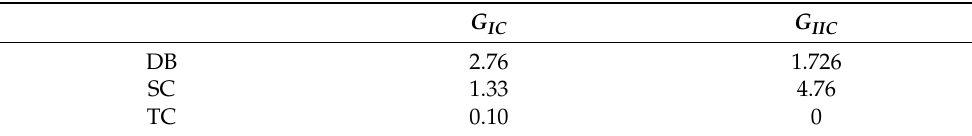
Table 2. COV between fracture toughness and residual